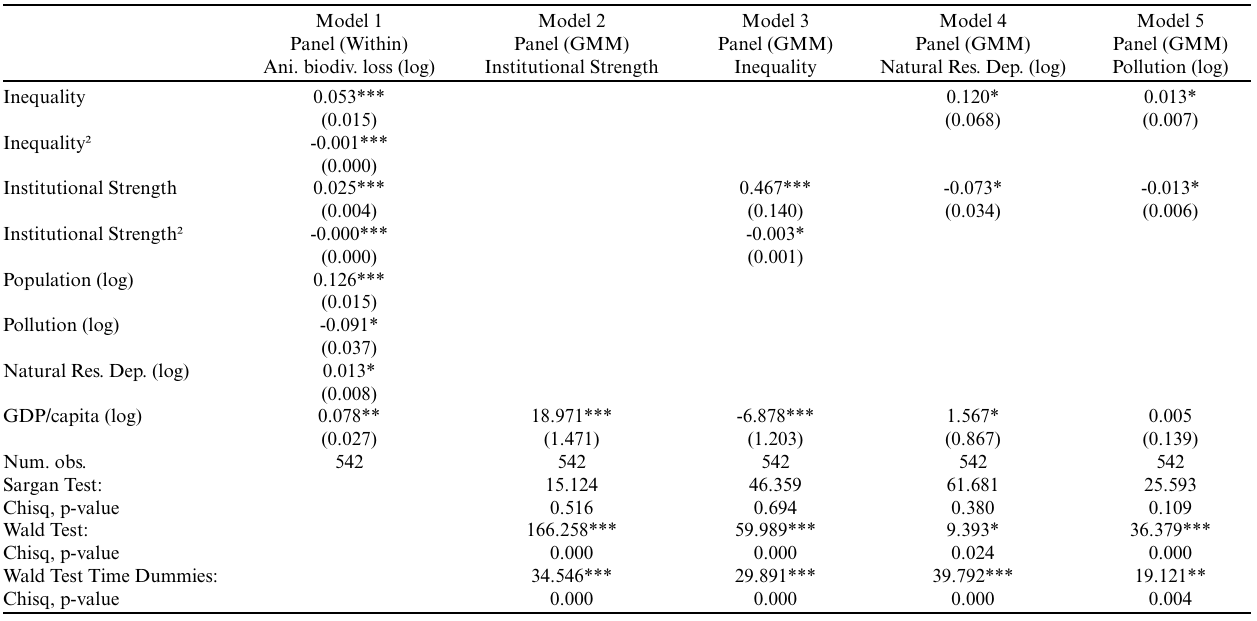
Table 2 . Model results for animal biodiversity loss (direct and indirect